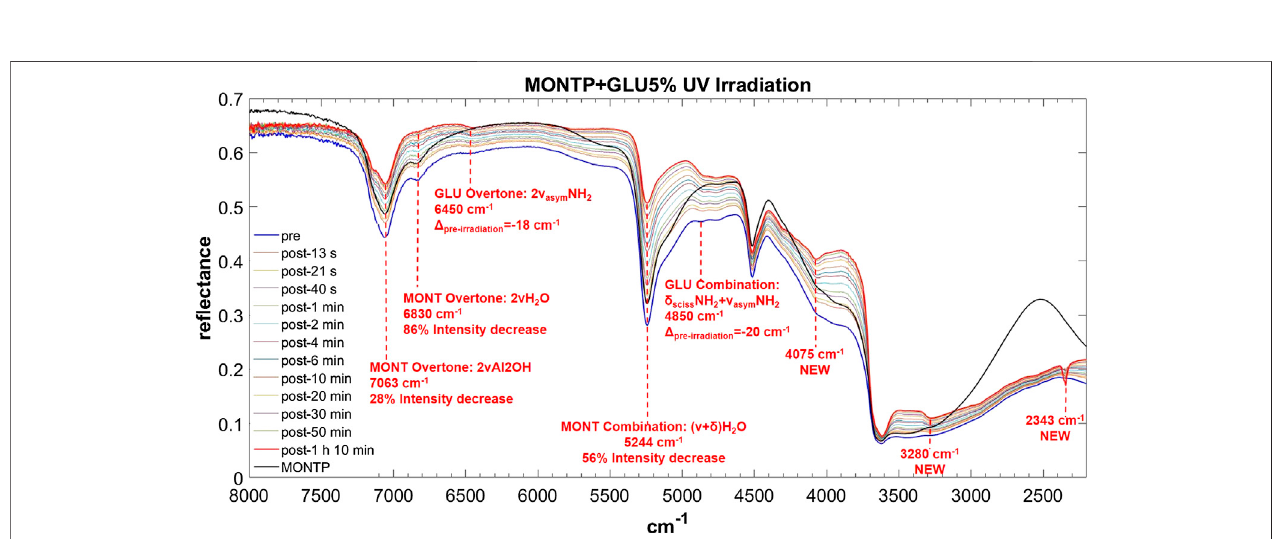
FIGURE 9 | Main changes in NIR features after 70 min of UV irradiation for GLU 5 wt% on montmorillonite containing 1 wt% of Mg-perchlorate. Legend: Δ pre-irr (cid:2) wavenumber shift with respect to the same peak pre-irradiation; ν (cid:2) stretching vibrational mode; δ (cid:2) bending vibrational mode; sciss (cid:2) scissoring in-plane vibrational mode; asym (cid:2) asymmetric vibrational